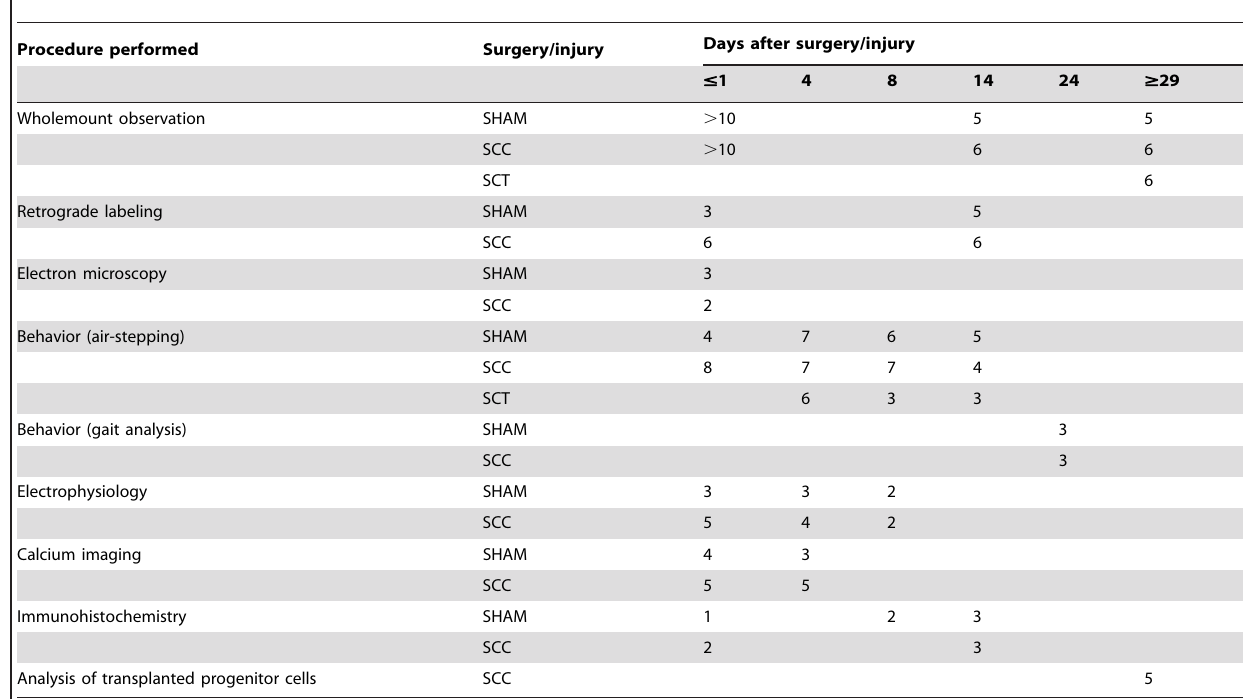
Table 1. Summary of the number of mice used for each procedure performed at different timepoints after injury (SCC, SCT) or surgery